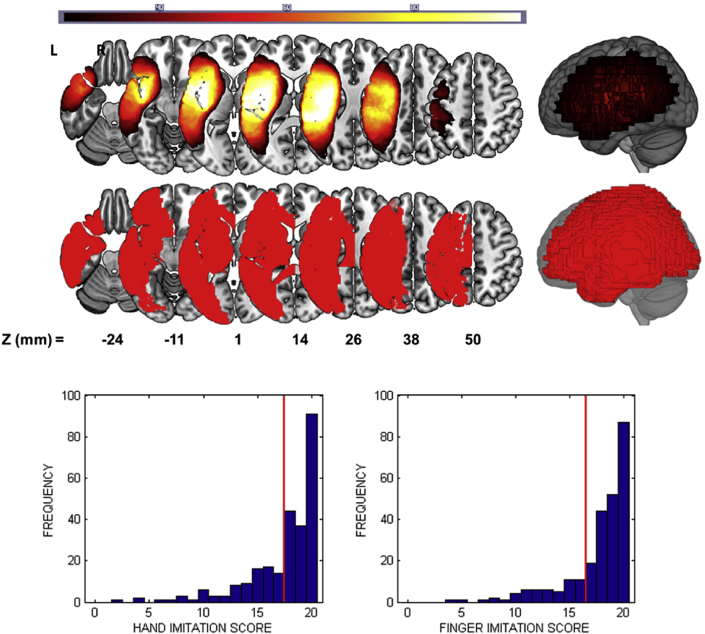
(Top) A lesion frequency image for the 257 patients in our sample. (Middle) An illustration of the union of regions that we consider in the region-based analyses. Both the voxel-based and region-based maps are thresholded to include only those voxels/regions where at least 26 patients (10% of the sample) had damage. (Bottom) Histograms of the patients' scores in the (left) hand and (right) finger imitation tasks. Red lines in each histogram indicate the threshold below which patients were considered ‘impaired’ on that task.